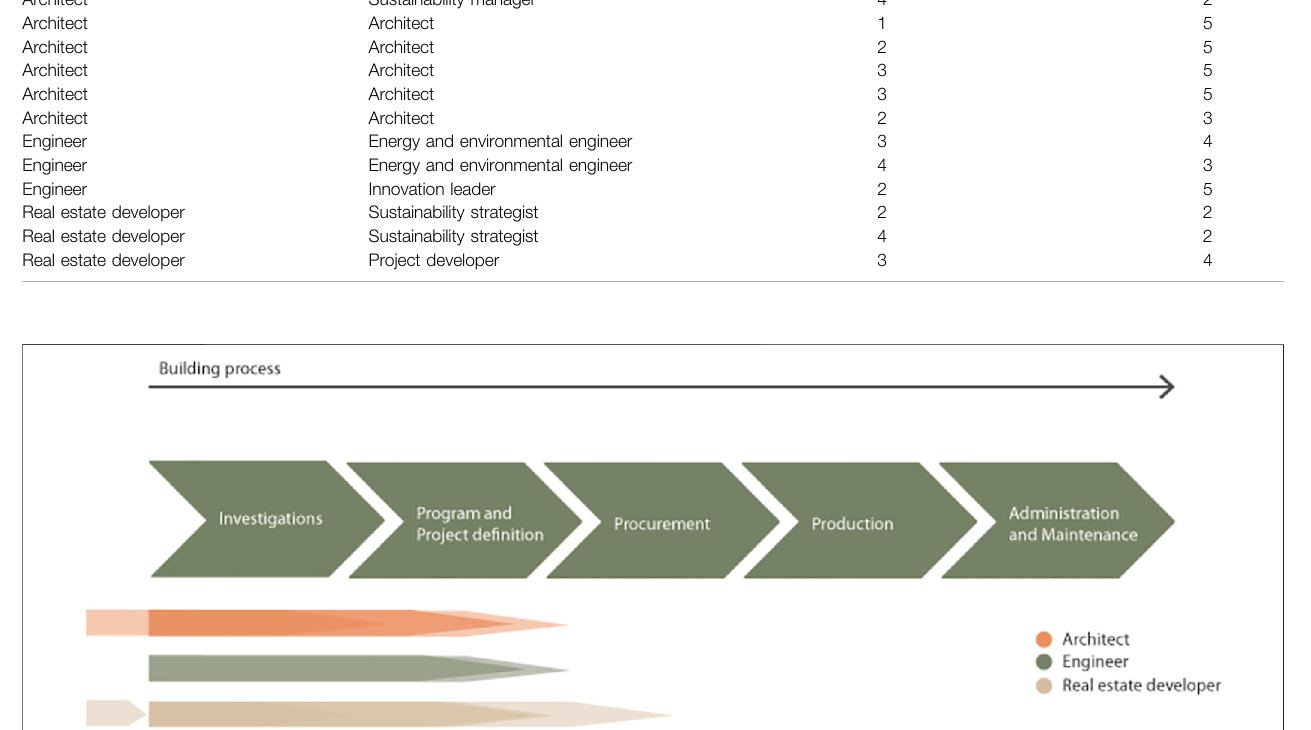
FIGURE 3 | De fi nition of early stages.